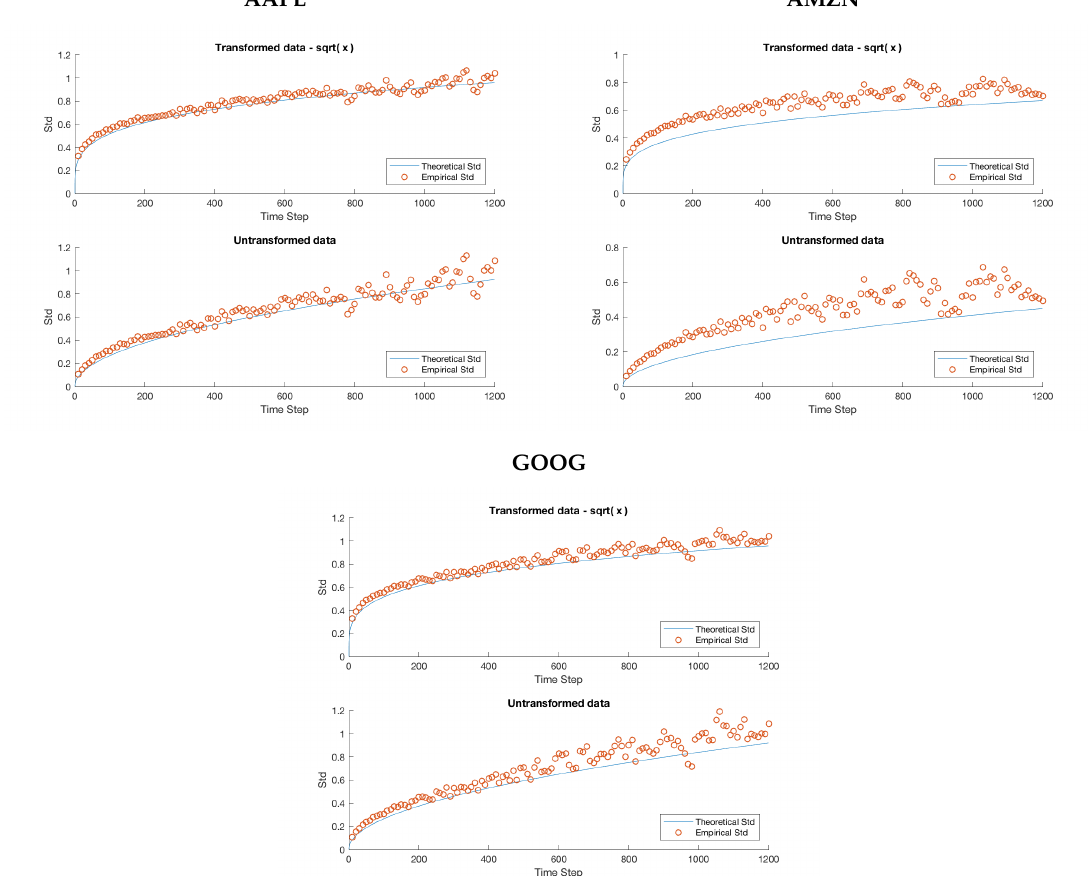
Figure 5. A comparison of the empirical standard deviation for a fixed window size n to the theoretical standard deviation for AAPL, AMZN and GOOG using the 2-state dependent order model. We have plotted the empirical standard deviation for all n from 10 s to 20 min in step sizes of 10 s. Each empirical standard deviation corresponds to a single point in the scatter plot and the plotted curve corresponds to the predicted theoretical value. Visually, there is a significant improvement for all stocks, although the theoretical standard deviation for AMZN is still underestimating the empirical